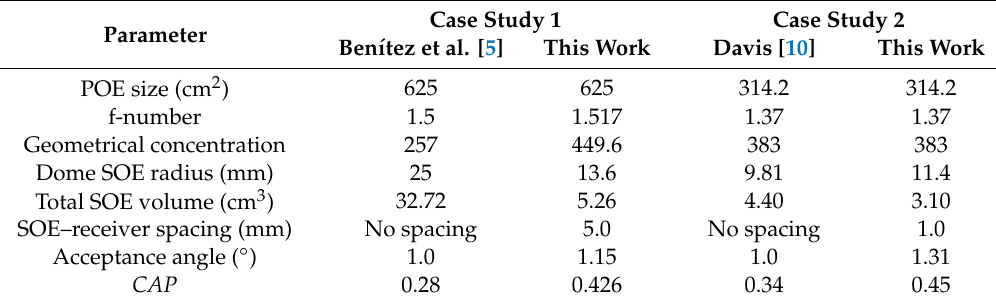
Table 1. Results comparison with the literature’s case